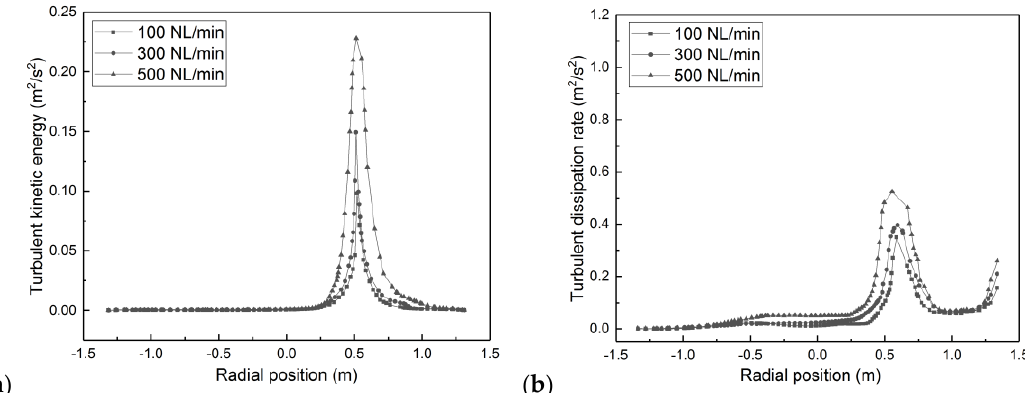
Figure 6. Turbulent kinetic energy profiles for different gas flow rates from the ladle bottom: ( a ) 1.5 m ( b ) 3.0 m.